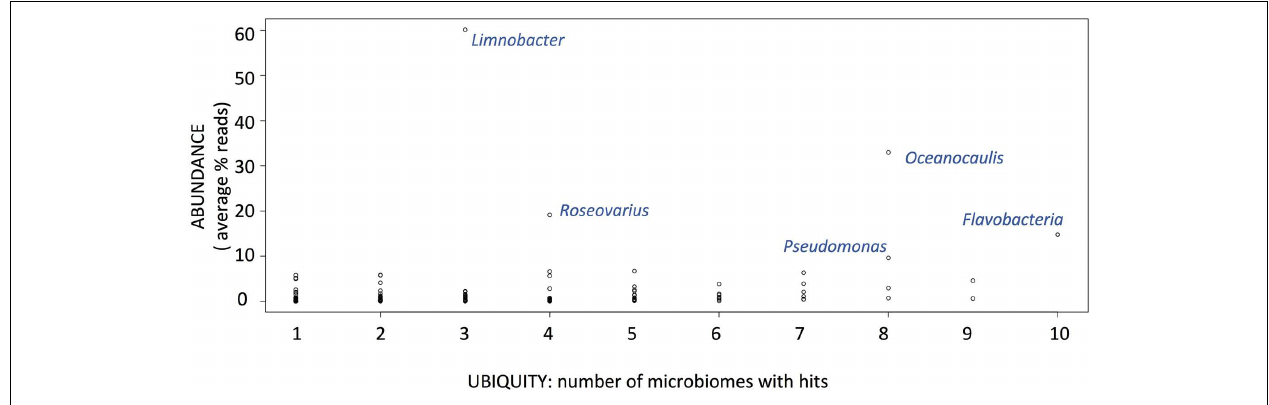
FIGURE 2 | Ubiquity versus abundance (average % of reads across microbiomes where the group is present) of bacterial groups after MGRAST analysis of the 13 microbiomes.